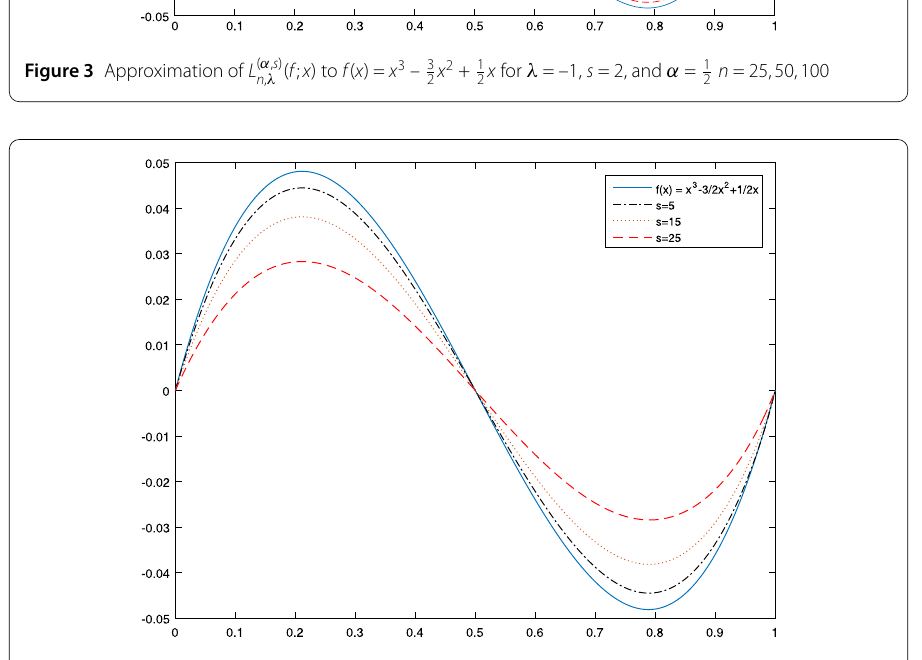
( f ; x ) to f ( x ) = x 3 – 3 n , λ